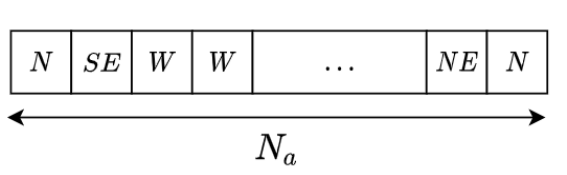
Figure 6. Individual representation. Every individual is a list of T actions. One for every timestep t of the trajectory.